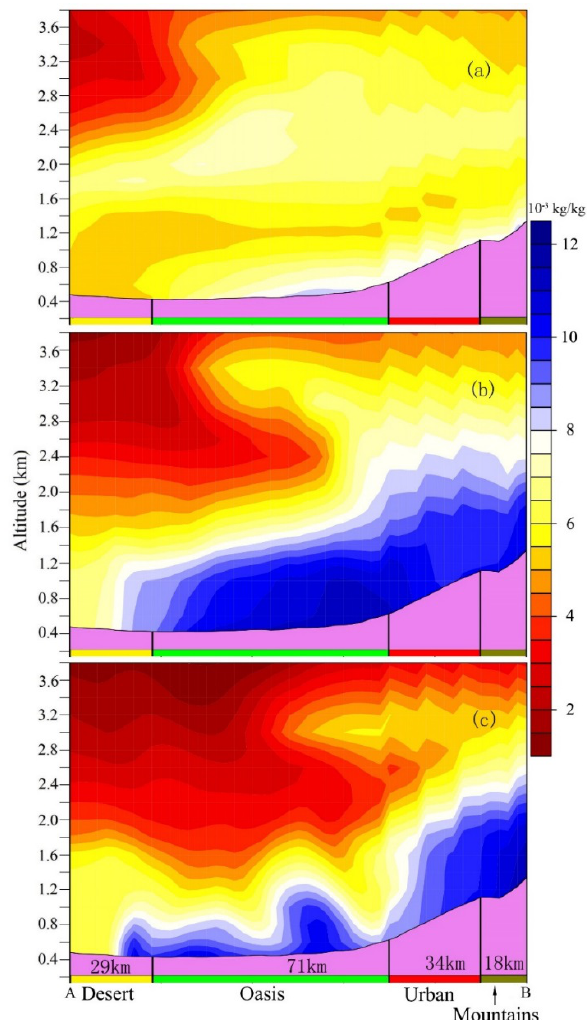
Figure 9. The vertical cross sections of specific humidity (10 − 3 kg / kg) along AB (the green line in Figure 7a) at 09:00 ( a ), 16:00 ( b ) and 21:00 ( c ) BJT on the 11 June 2016. The violet shaded areas at the bottom of each panel represent the terrain; along the x axis (from A to B) the yellow bar represents the extent of the desert; the green bar represents the extent of the oasis; the red bar represents the extent of the urban area; the olive bar represents the extent of mountain areas and the number represents the width of the land use type.